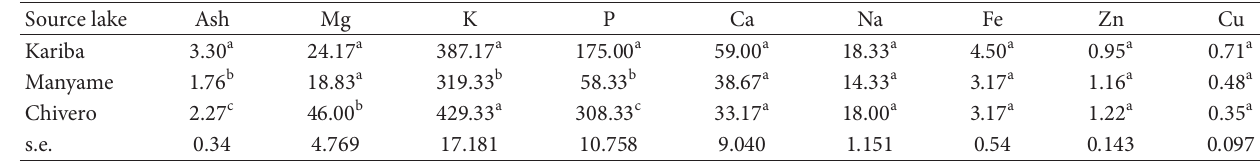
Table 4: Ls mean ash (%) and mineral (mg/100g) content of fish from three water bodies. Source